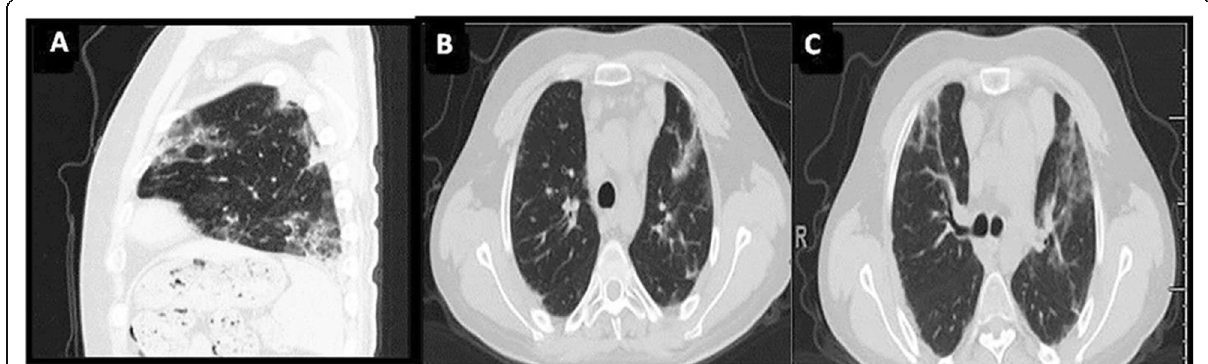
Fig. 8 Fourth-week follow-up chest CT of a female patient aged 12 years old with ALL and receiving chemotherapy, who developed COVID-19 infection presenting with dyspnea, tachypnea, and fever. The patient needed O 2 at the time of presentation. The initial chest CT severity score was 18 and, 1 month later, there were residual consolidation patches, linear opacities, crazy-paving patterns, and linear opacities. Chest